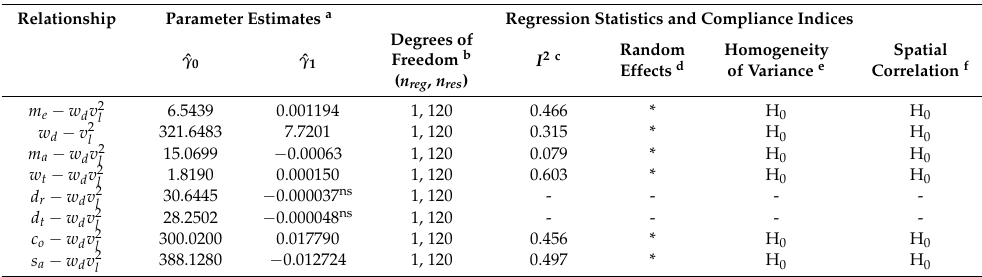
Table 7. Attribute-specific regression results for the mixed-effects model specification (Equation (5)): parameter estimates, regression statistics and compliance